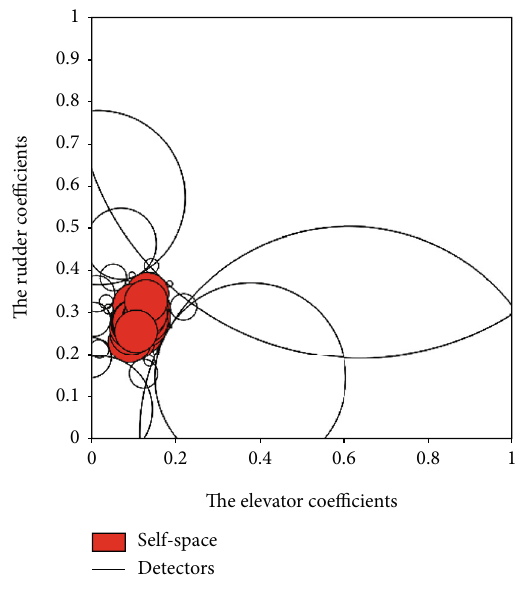
Figure 12: Detectors generation in this paper. Table 2: The number of detectors, detection rate, and false alarm rate of three